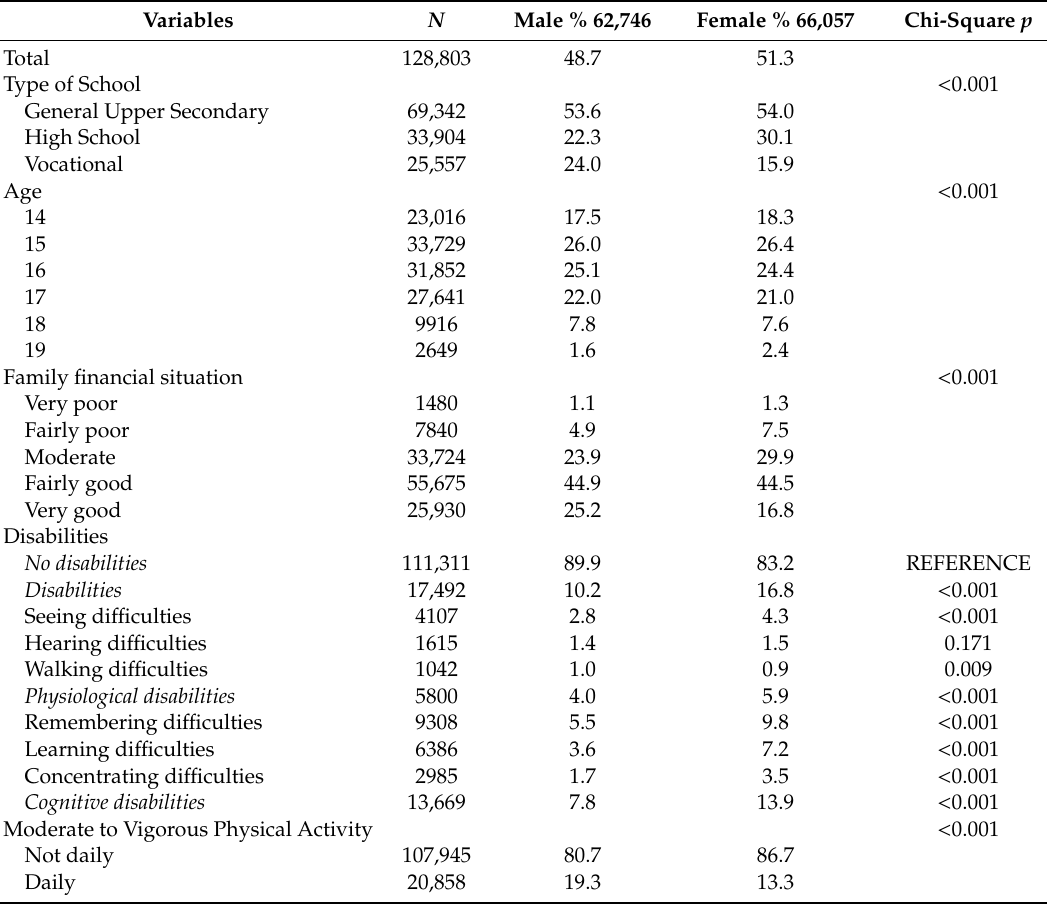
Table 1. Population descriptive statistics by